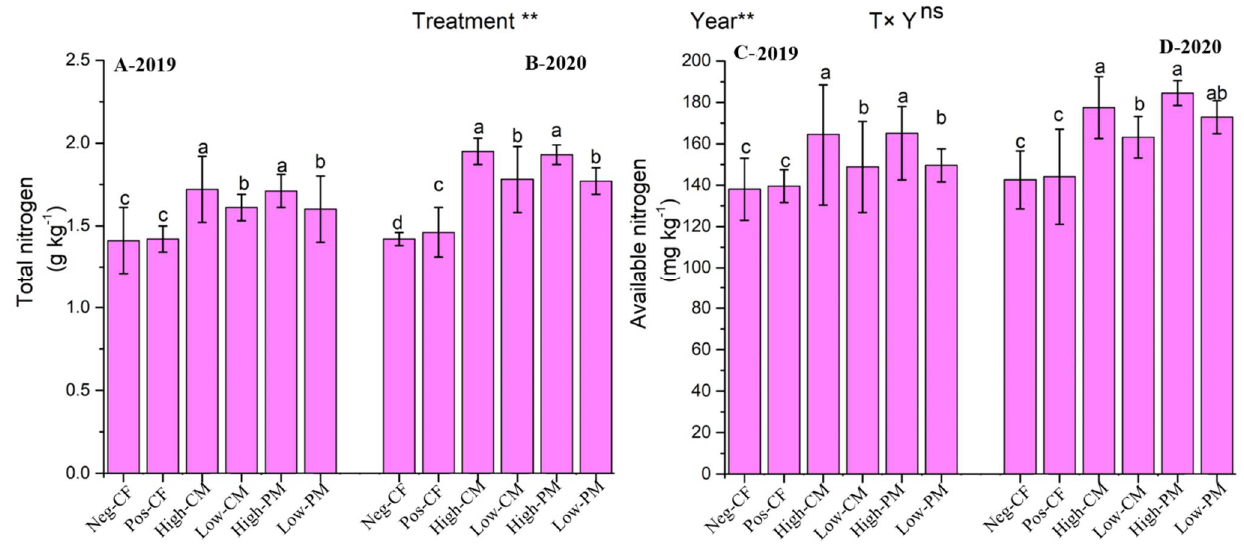
Figure 3. Changes in soil total nitrogen in the year 2019 ( A ) and 2020 ( B ) and soil available nitrogen in the year 2019 ( C ) and 2020 ( D ) as affected by integrated manure and chemical N fertilizer application. Means sharing the same letter within a category are not significantly different according to Tukey’s HSD test at p < 0.05. ** = significant at 1%, respectively and ns = non-significant. Please see Figure 2 for the treatment